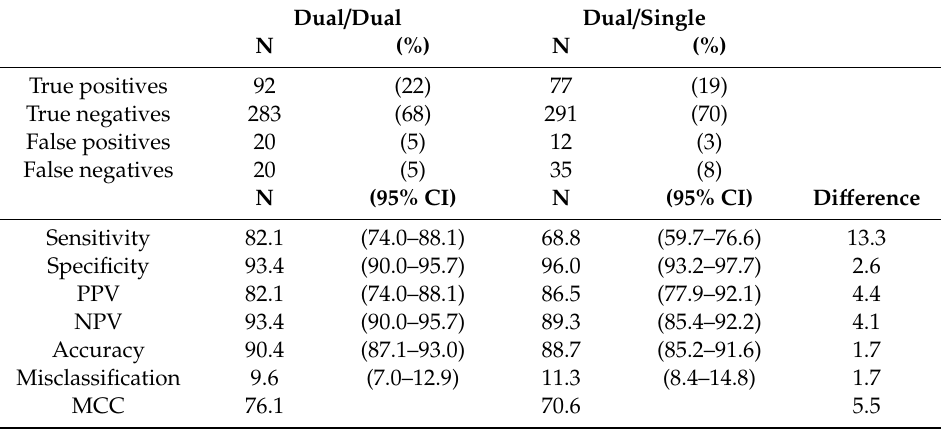
Table 2. Results—Per parathyroid gland. (106 patients, 415 parathyroid glands).